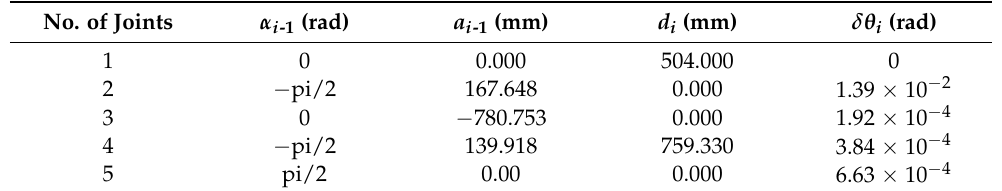
Table 5. The kinematic parameters of the ER20-C10 robot after calibration.